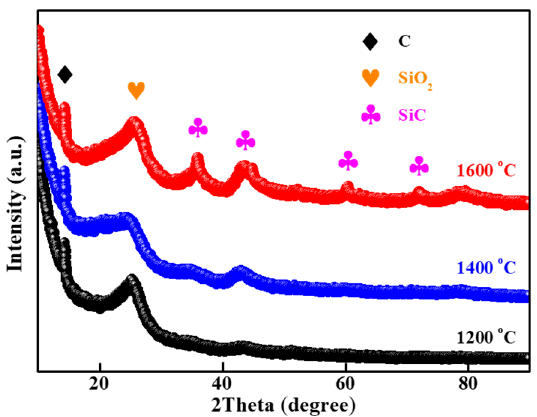
ff erent pyrolysis